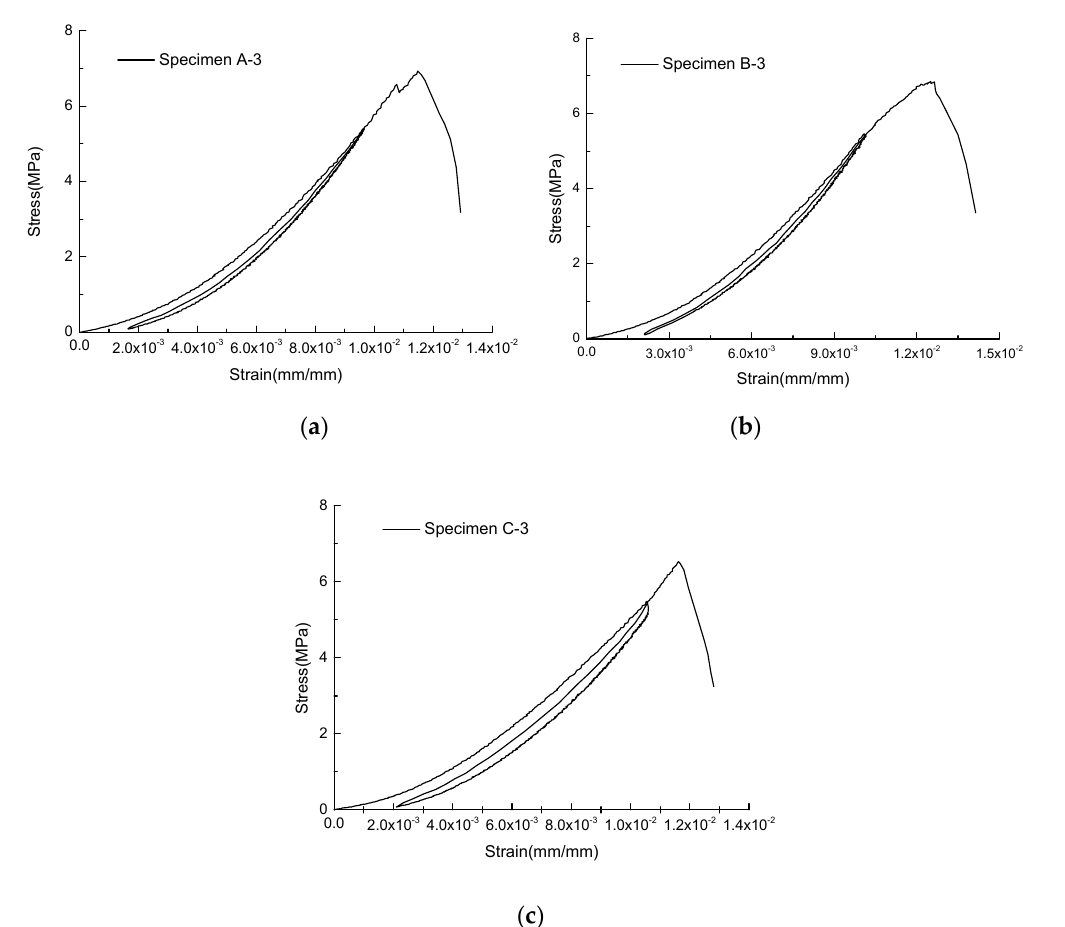
Figure 6. Representative loading-unloading stress–strain curves for each group: ( a ) Specimen A-3; ( b ) Specimen B-3; ( c ) Specimen C-3.